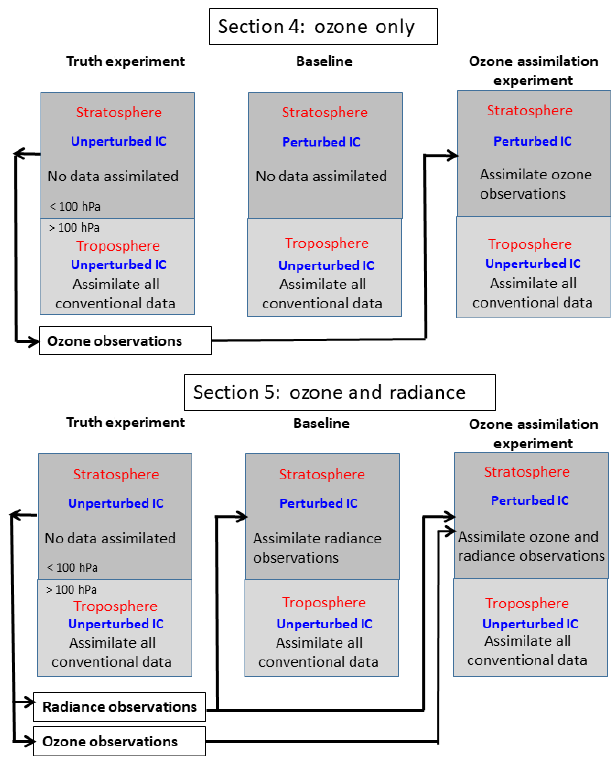
Figure 8. Schematic diagram to illustrate the design for the exper- iments analyzed in Sects. 4 and 5. The TE in both cases assim- ilates all conventional data in the troposphere (pressures greater than 100hPa) and no data in the stratosphere (pressures less than 100hPa). In Sect. 4, the baseline experiment is the same as the TE, except for perturbed initial conditions (IC) in the stratosphere. The ozone assimilation experiment for Sect. 4 assimilates ozone obser- vations created by the TE. In Sect. 5, the baseline includes assimila- tion of noisy radiance observations created from the TE. The ozone assimilation experiment in Sect. 5 includes both radiance and ozone observations from the